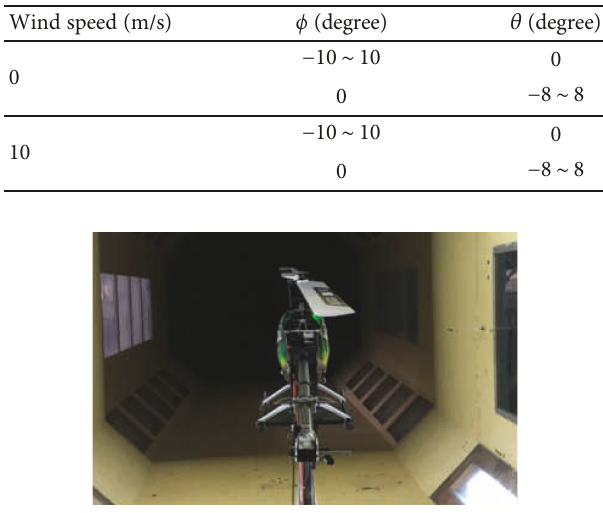
Figure 12: Blow air test of the main rotor.